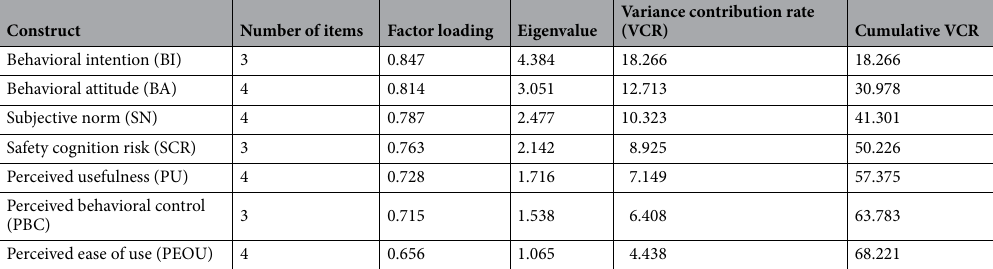
Table 1. Results of exploratory factor analysis.